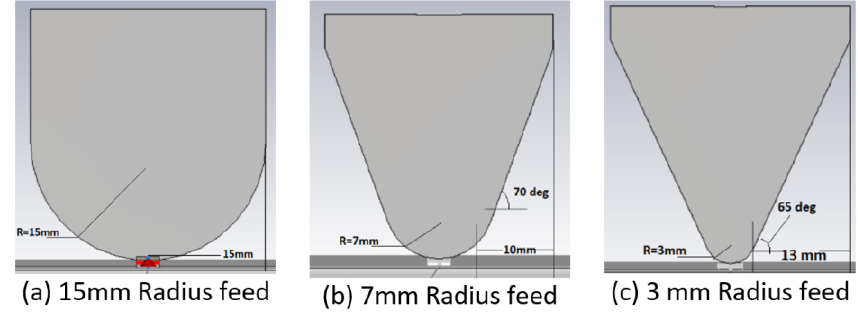
Figure 8. Short-structure feeding